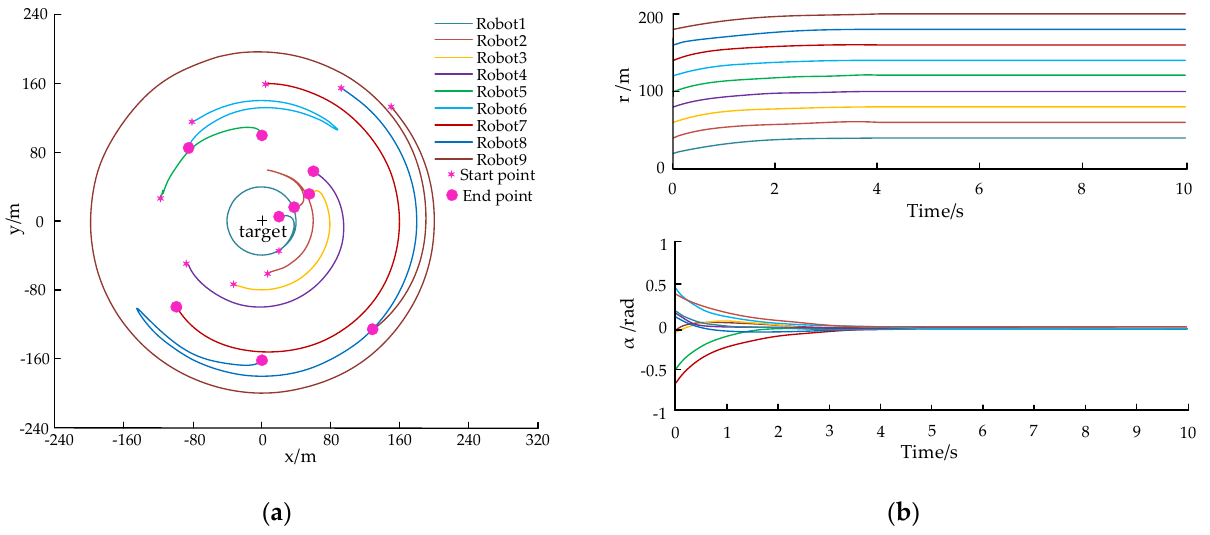
Figure 13. ( a ) Trajectories of nine robots on the plane by PFC in spiral formation; ( b ) Formation position error of each following robot.